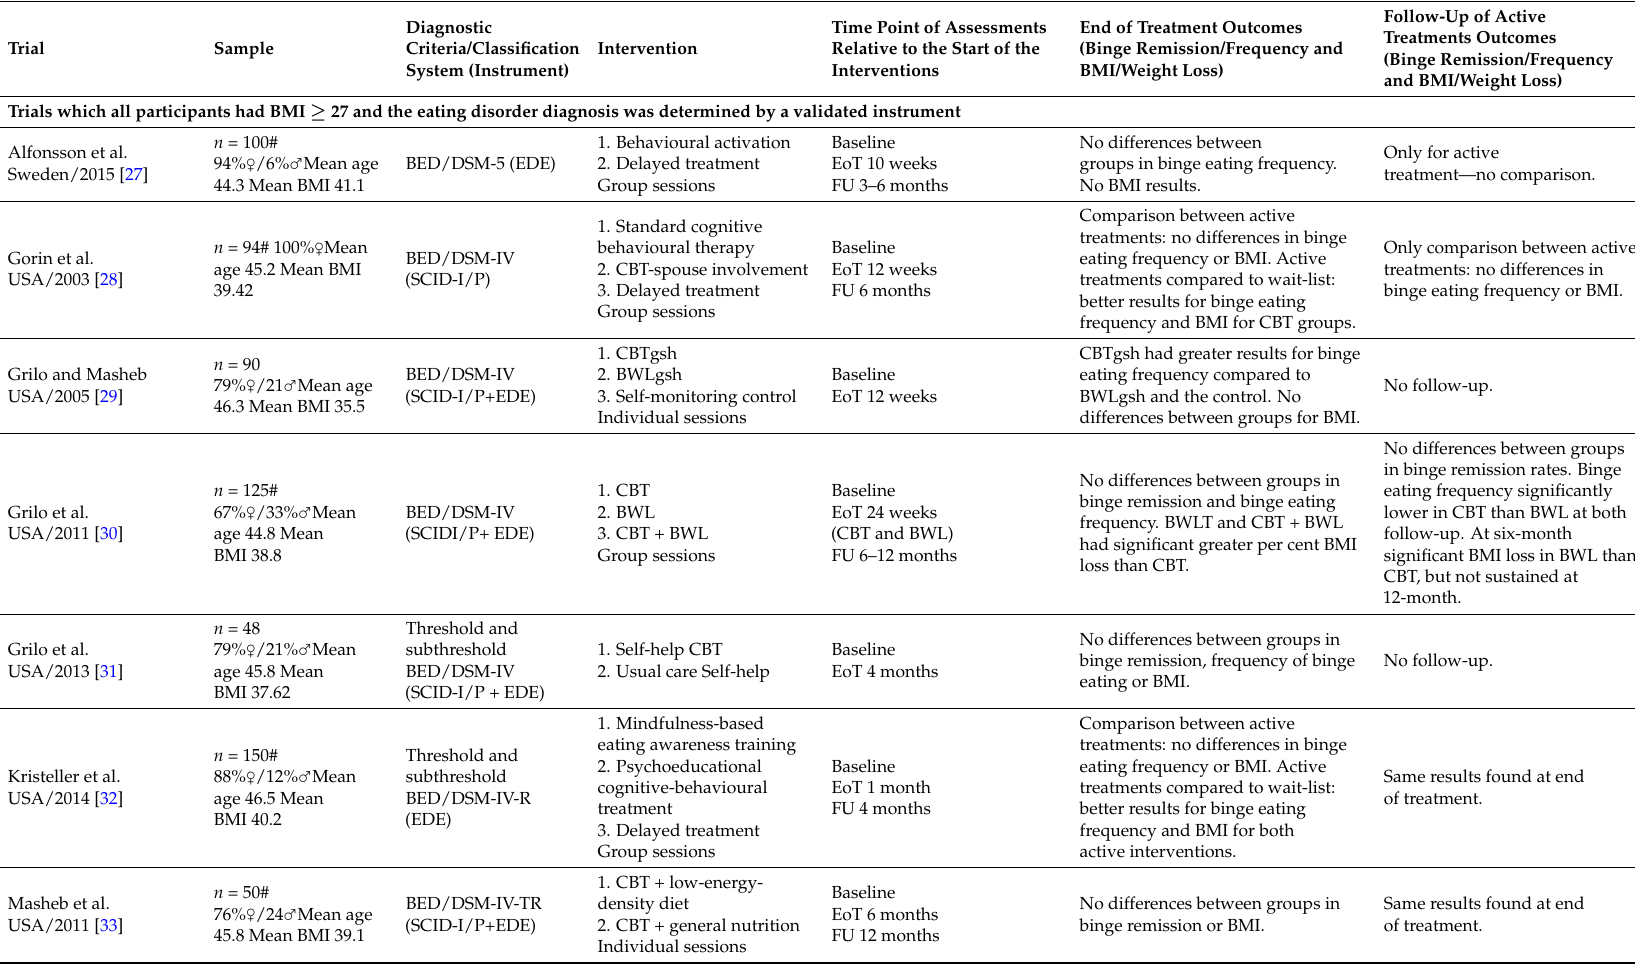
Table 1. Features of included randomized controlled